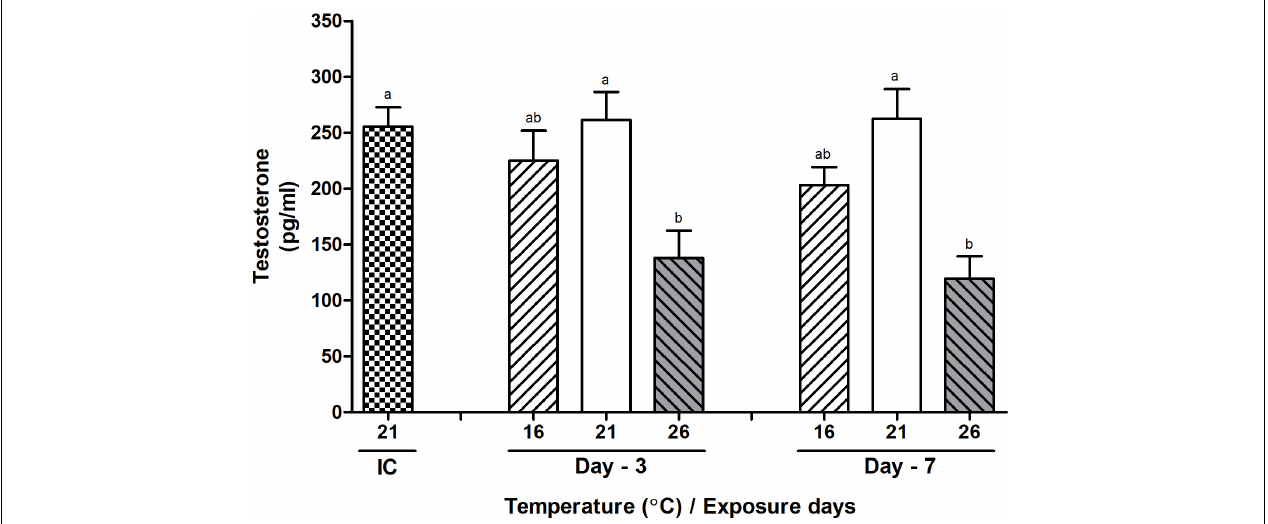
FIGURE 11 | Changes in the levels of testosterone in the hemolymph of male Pacific abalone during the peak breeding season after exposure to thermal stress for 7 days. Before exposure to the target temperature of thermal stress, abalone were sampled to obtain reference values that served as initial control (IC). Values represent the mean ± SD ( n = 10). Different letters on the bar indicate significant differences among different temperature groups ( p < 0.05).